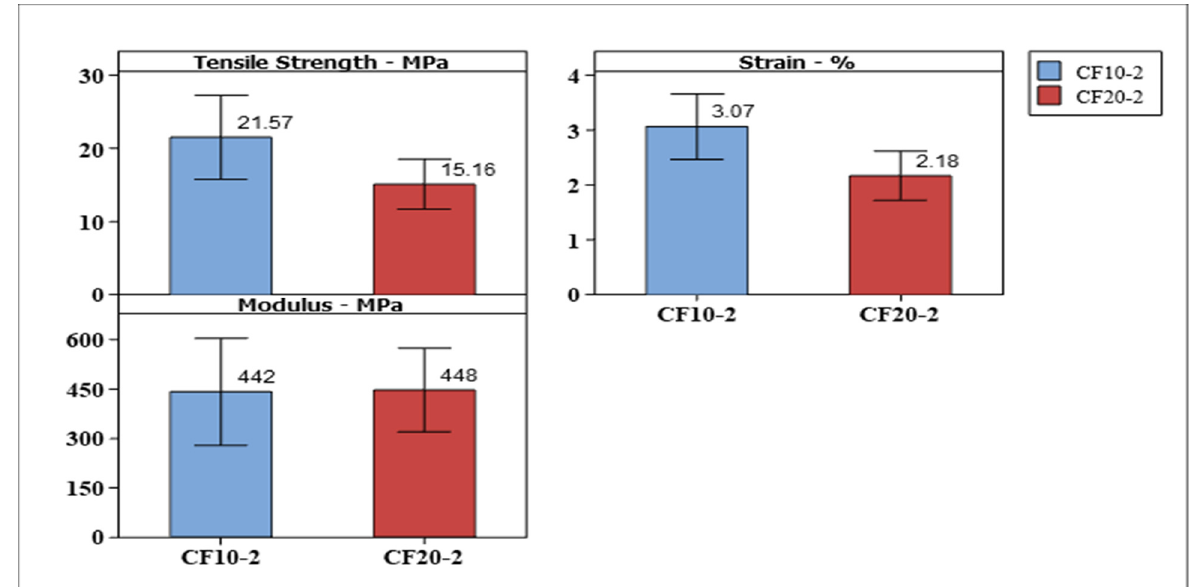
Fig. 10: Tensile Properties of bagasse-cotton fabric reinforced